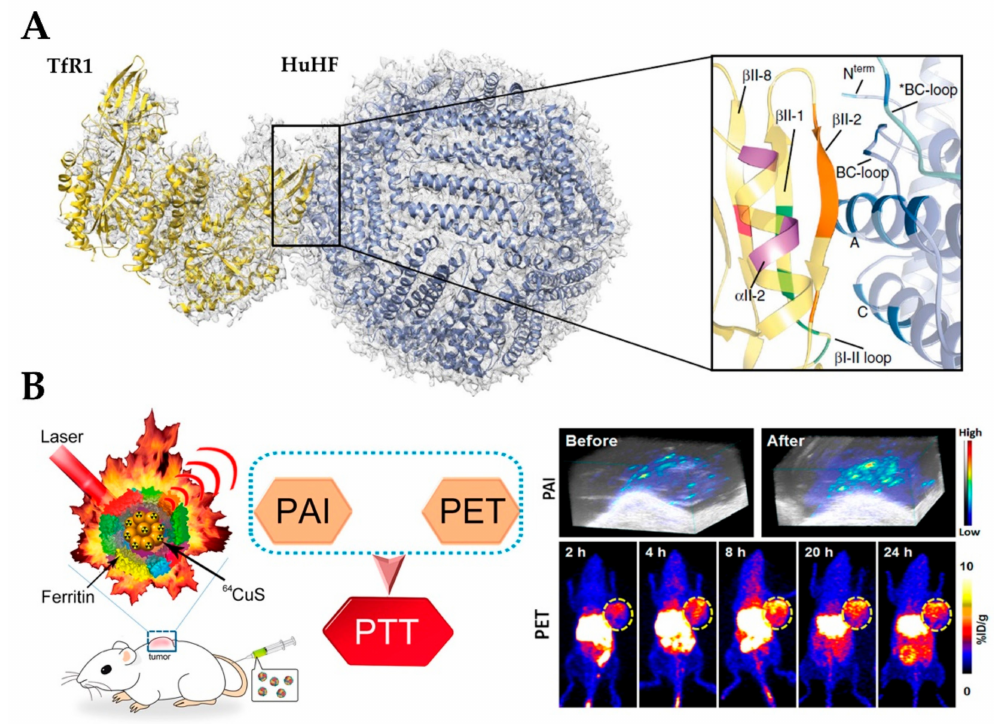
Figure 6. ( A ) Atomic model of the complex of TfR1 (yellow) and HuHF (light blue) fitted in the cryo-EM map Reproduced with permission from [120], Nat. Commun. , 2019). ( B ) 64 CuS–Fn NCs as clinically translatable cancer theranostics for positron emission tomography and photoacoustic dual-modality imaging (PET / PAI) dual-modal imaging guided photothermal therapy (PTT) (Reproduced with permission from [57], ACS Nano , 2016). NC,